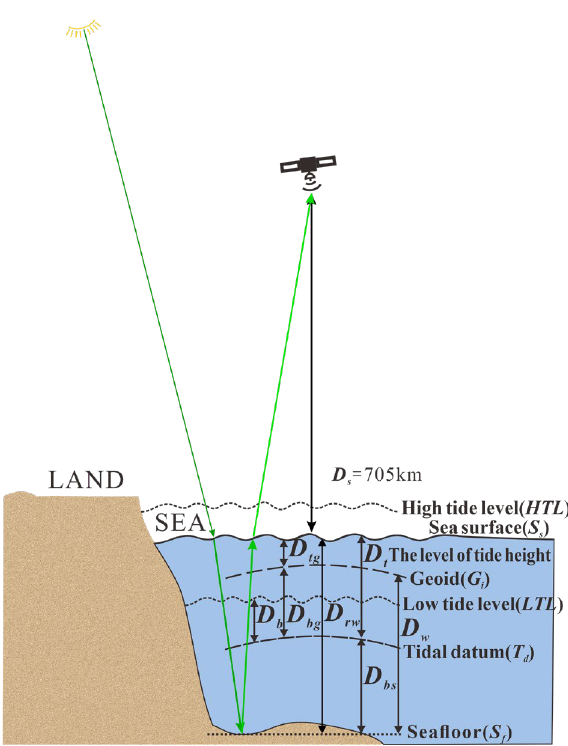
Figure 1. Principle of tidal fluctuation impact at the epoch of satellite flight, where D s represents the distance between satellite and sea surface, D bg represents the distance between the geoid and tidal datum, D tg represents the distance from the level of sea surface to the geoid; D t represents the distance from the level of sea surface to tidal datum; D bs represents the distance between the tidal datum and the sea floor; D w represents water depth, which is indeed the distance between the geoid and the seafloor; D rw represents water depth, which is indeed the distance between the level of sea surface and the seafloor.